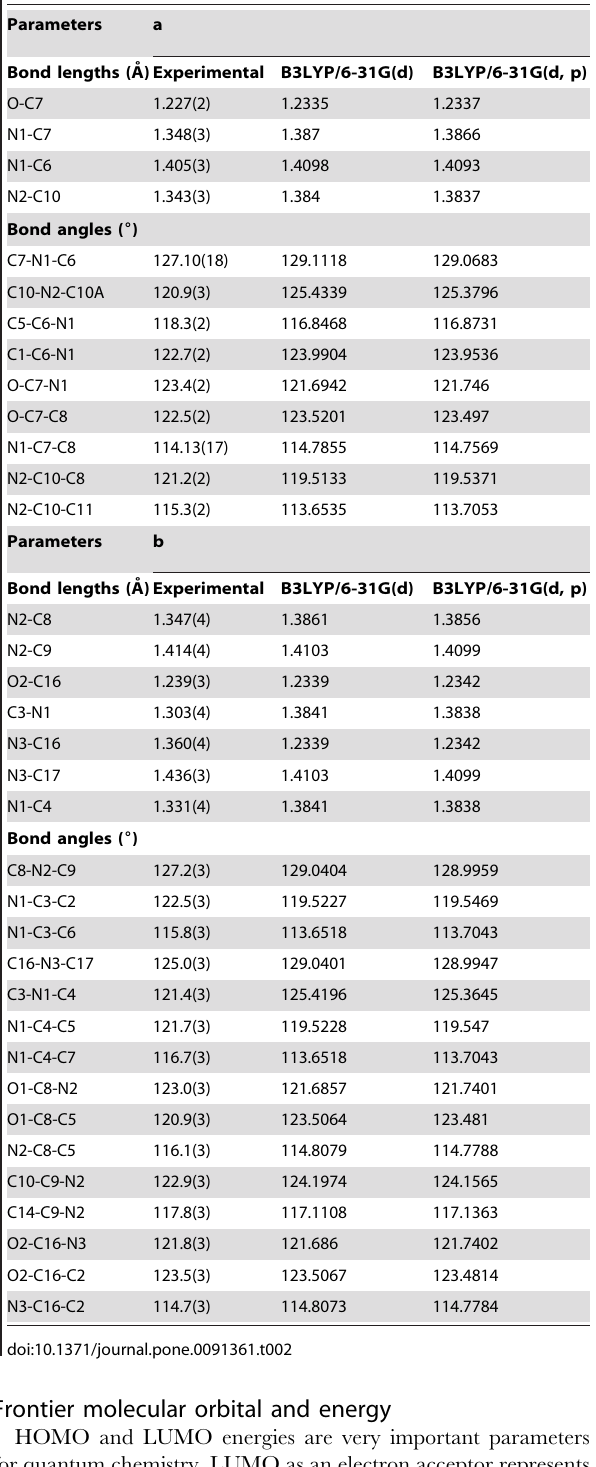
Table 3. Parameters (A˚, u ) for the intra- and intermolecular interactions in a and b.